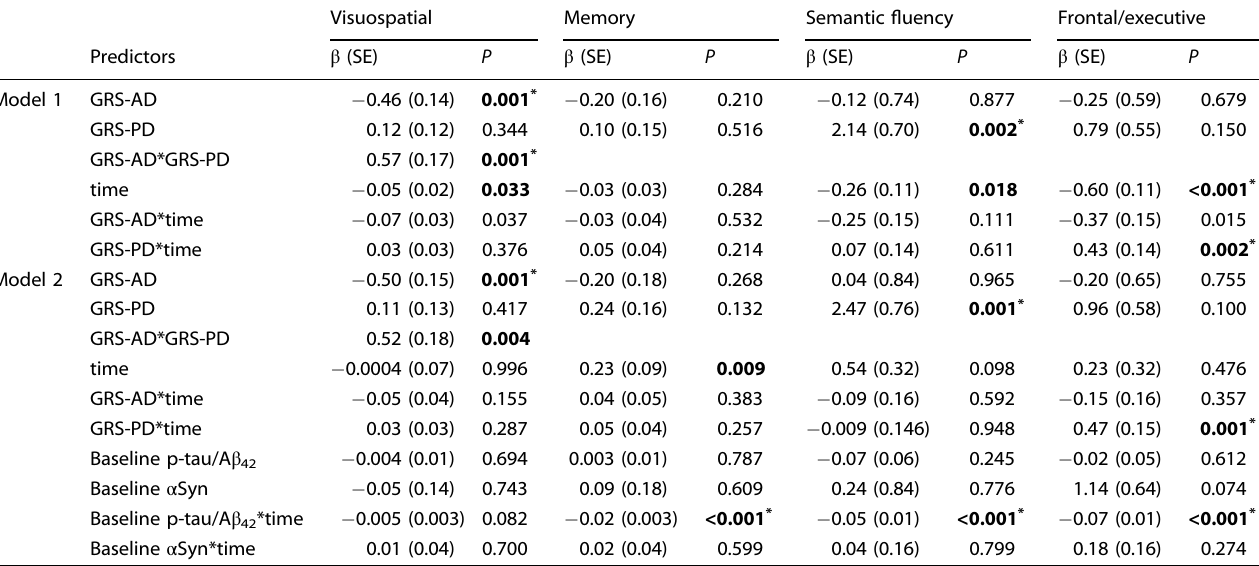
Table 4. Effects of genetic risk scores and CSF biomarkers on longitudinal cognitive changes in PD patients.